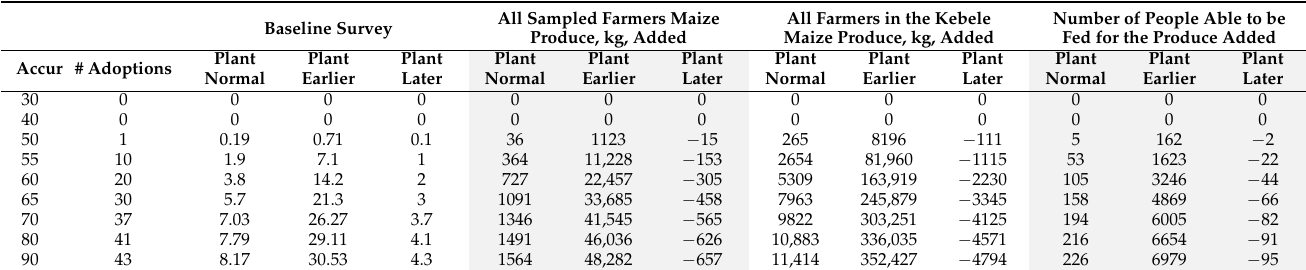
Table A11. Adoption rate of weather forecast accuracy, crop productivities of adopted numbers, and number of people able to be fed under more rain conditions. Baseline